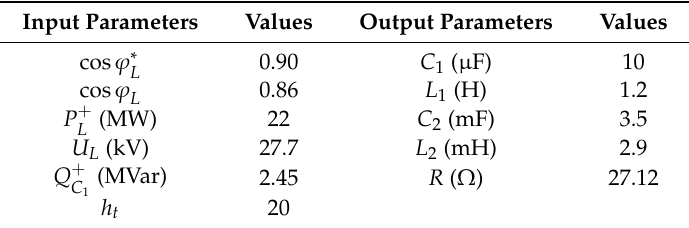
Table 3. The key parameters of the